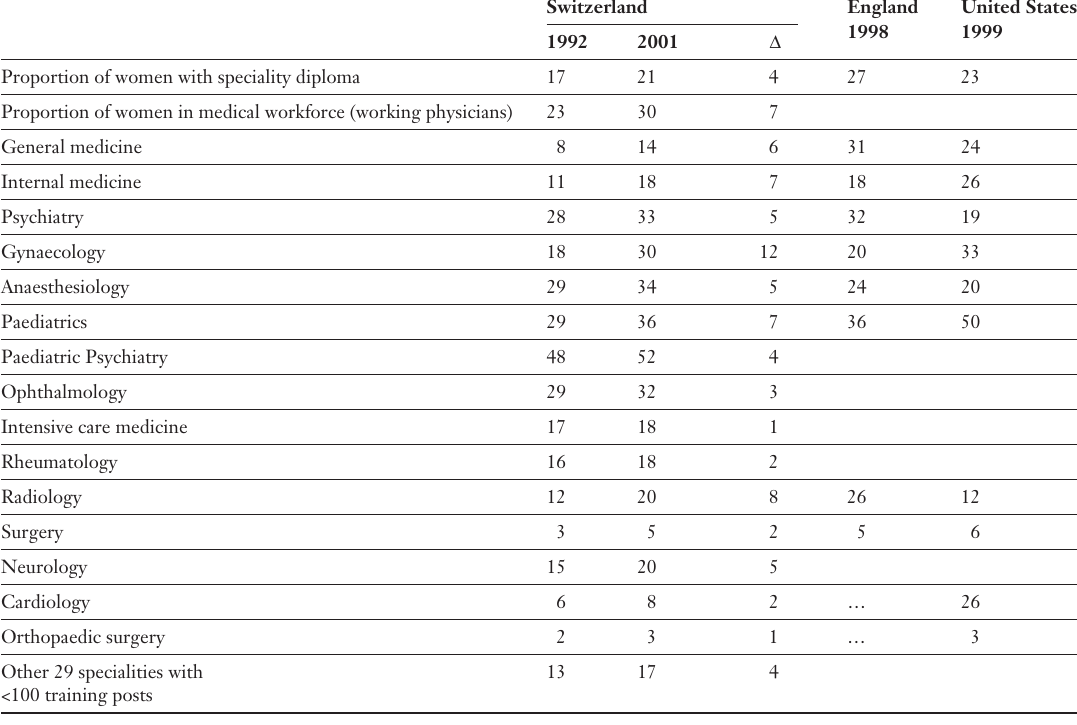
Proportion of female physicians in the medical workforce in Switzerland 1992 and 2001. Data from England and USA according to